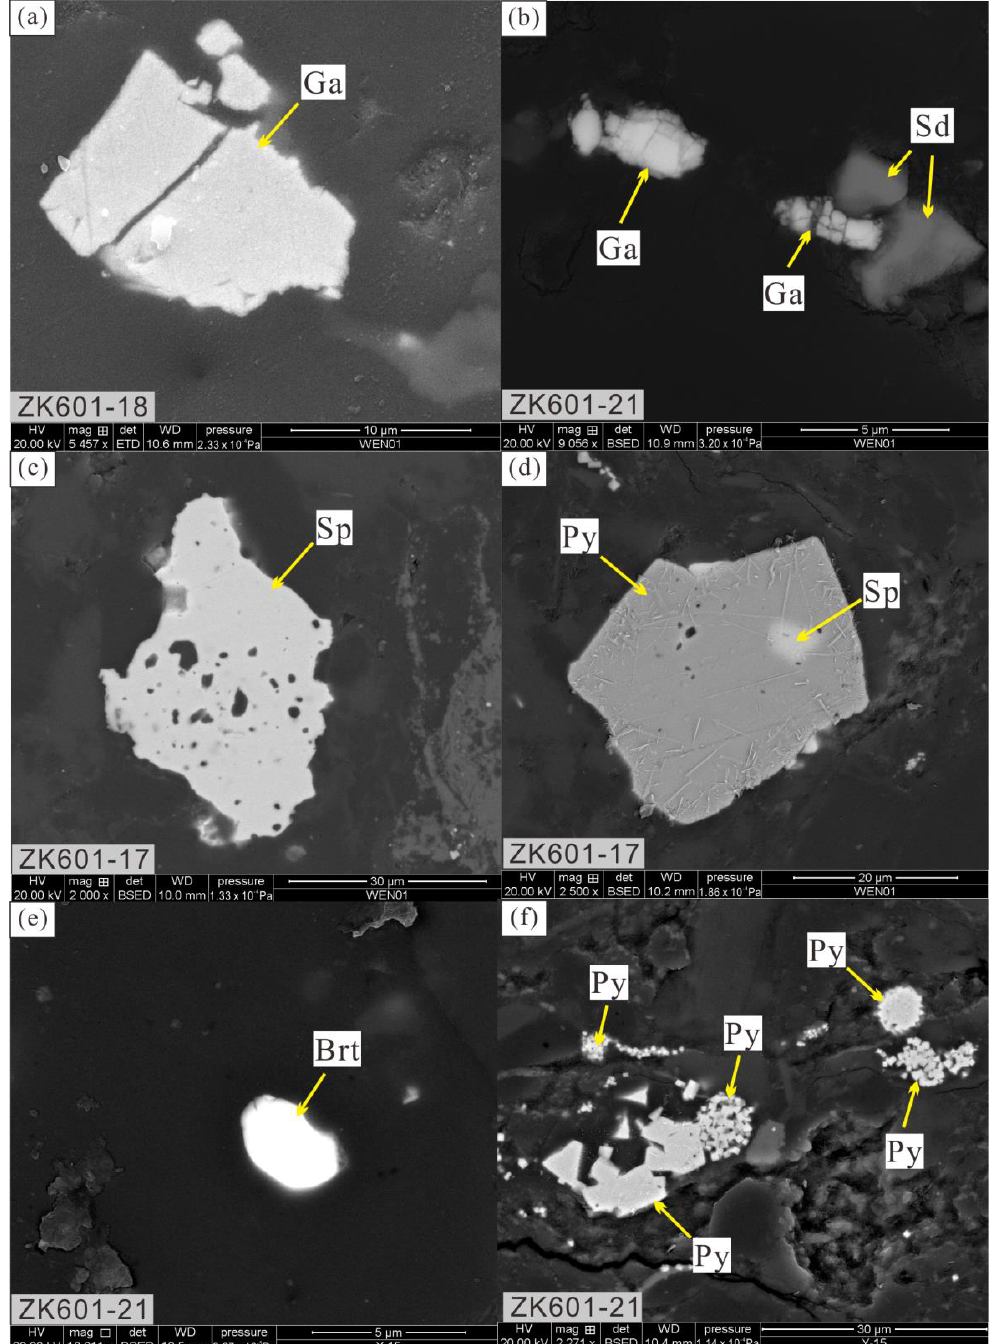
Figure 8. SEM observation results of source rocks at Xuequ (sample Nos.: ZK601-17, ZK601-18 and ZK601-21). ( a ) A galena in the source rocks; ( b ) Somegalenas and siderite in the source rocks; ( c ) Asphalerite in the source rocks; ( d ) A pyrite in the source rocks, sphalerite is encased in the interior of the pyrite; ( e ) Abarite in the source rocks; ( f ) Someeuhedral-subhedral granular pyrites and mildew spherical pyrites in the source rocks. Sp sphalerite, Ga galena, Py pyrite, Sd siderite, Brt barite.